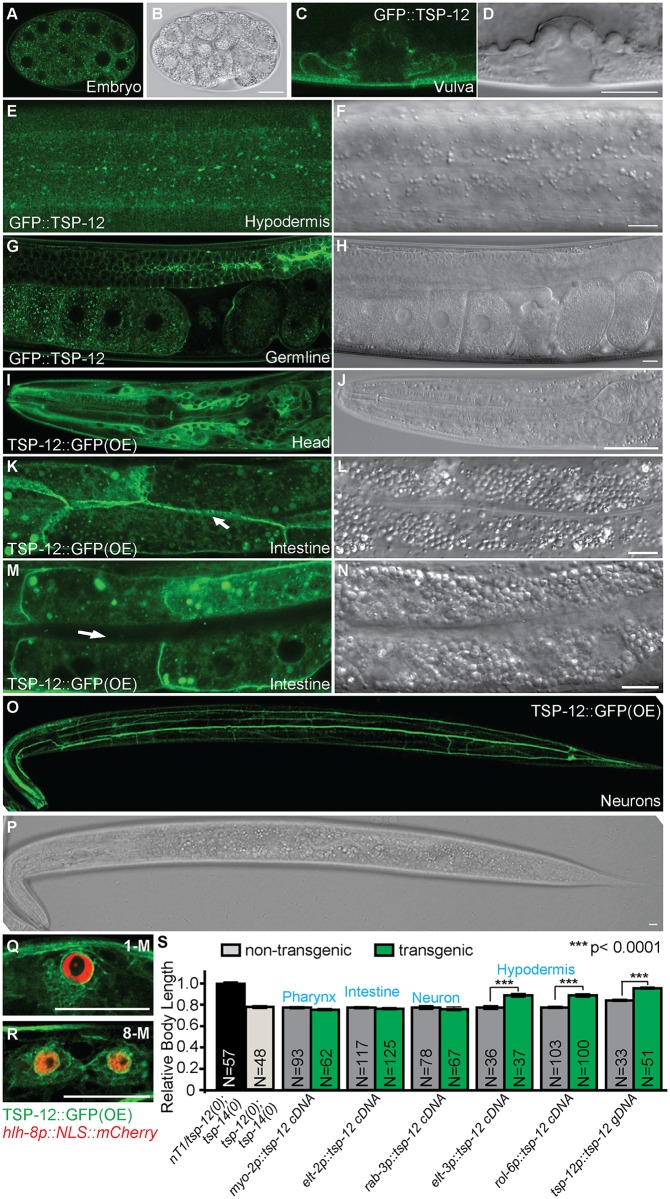
TSP-12 is localized both to the cell surface and in cytoplasmic vesicles in multiple cell types, including known Sma/Mab signal-receiving cells.(A-P) Confocal fluorescent images (A, C, E, G, I, K, M, O) and corresponding DIC images (B, D, F, H, J, L, N, P) of transgenic worms expressing endogenous GFP::TSP-12 (A, C, E, G) or over-expressed (OE) TSP-12::GFP (I, K, M, O) in the early embryo (A), L4 developing vulva (C), late L3 hypodermis (E), young adult gonad (G), L3 larva head (I), L4 intestine (K: basolateral focal plane of the intestine and the arrow points to the lateral membrane, M: middle focal plane of the intestine and the arrow points to the apical lumen of the intestine), and L3 neurons (O). (Q and R) L1 transgenic animals carrying both over-expressed TSP-12::GFP and the M lineage specific reporter hlh-8p::NLS::mCherry. TSP-12::GFP is present in M lineage cells from 1-M (Q) to 8-M (R) stages. Some M lineage cells are out of the focal planes shown. Scale bars represent 10μm in A-R. (S) Rescue of the small body size of tsp-12(ok239); tsp-14(jj95) worms produced by tsp-12(ok239)/+; tsp-14(jj95) mothers using tissue-specific tsp-12 cDNA expression. The mean body length of WT worms is normalized to 1.0. Error bars represent 95% confidence intervals for the normalized body length.